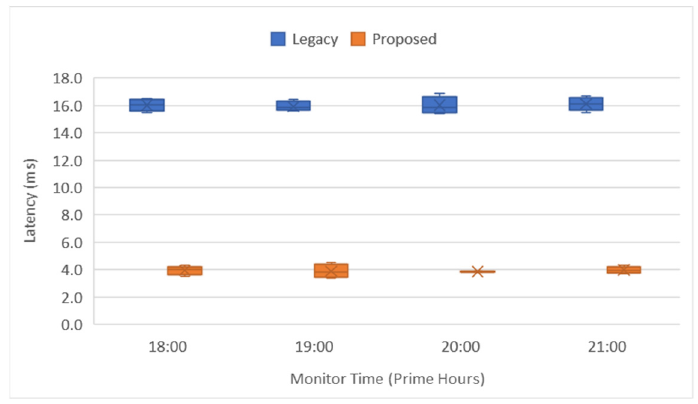
Figure 16. Server leaf switch latency—All week comparison.